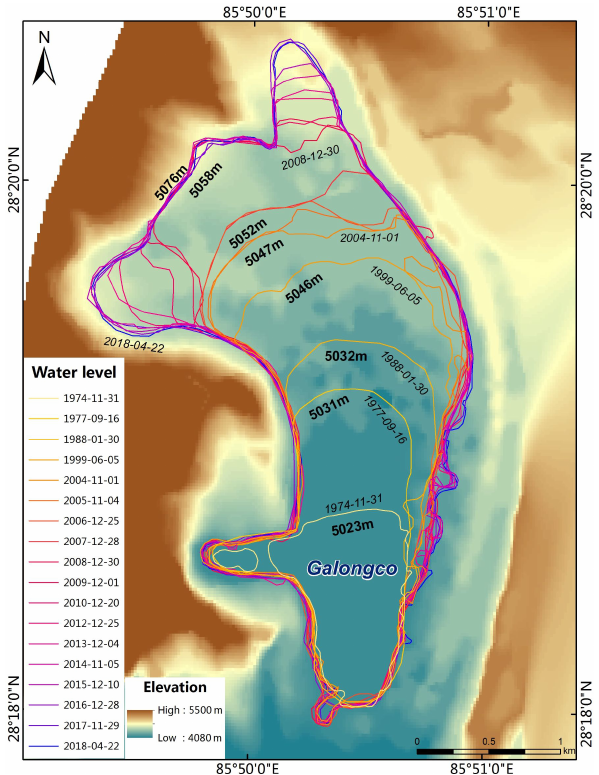
Figure 14. Terrain reconstruction of Galongco Lake below the wa- ter